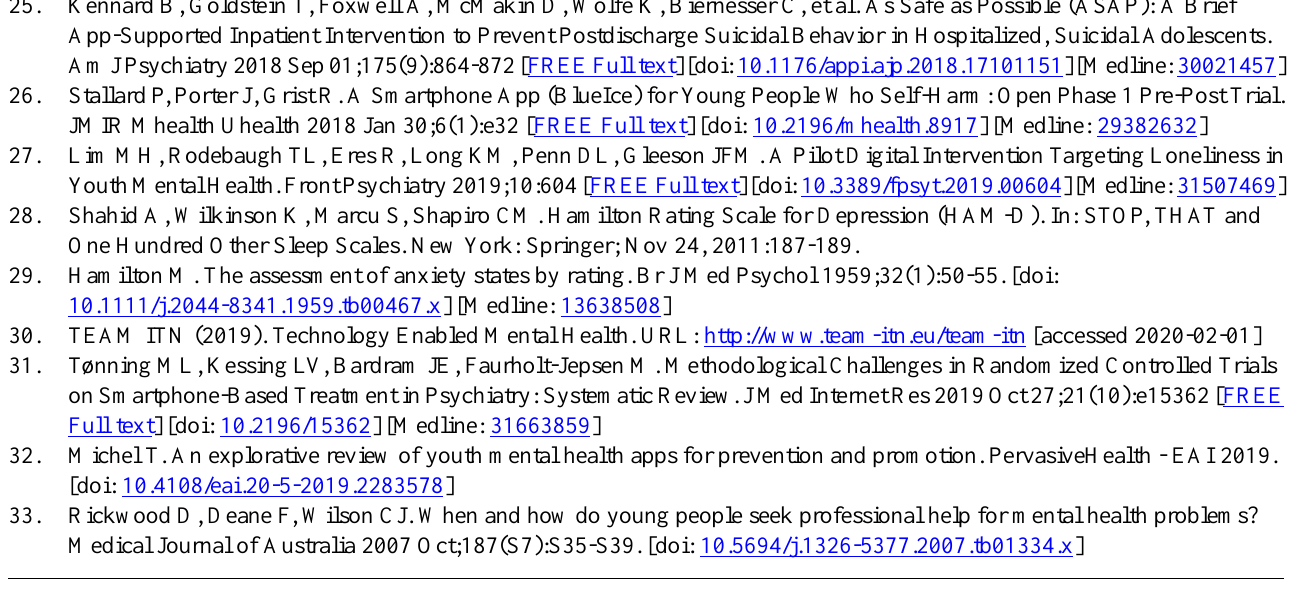
GRADE: Grading of Recommendations, Assessment, Development and Evaluations PRISMA: Preferred Reporting Items for Systematic Reviews and Meta-Analysis RCT: randomized controlled trial